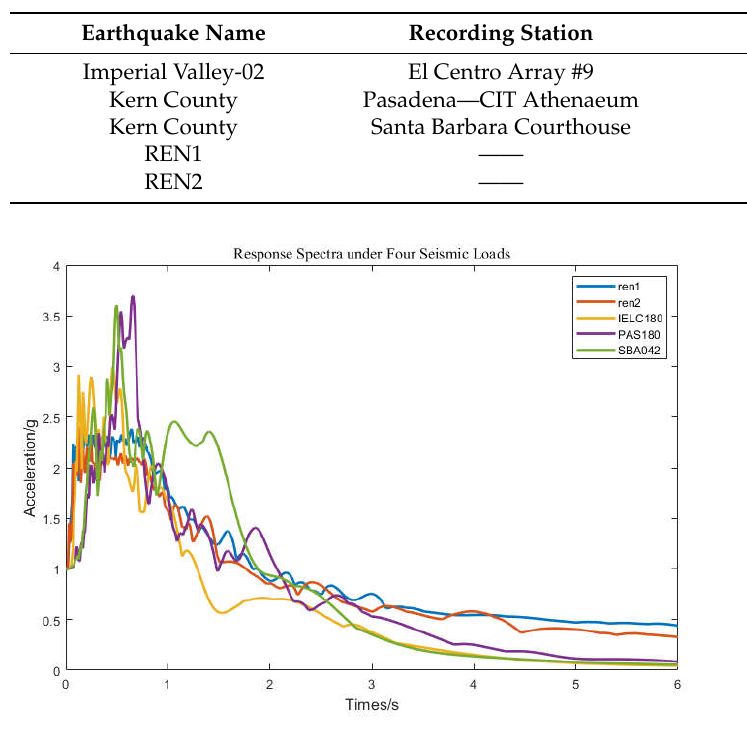
Figure 20. Seismic wave response spectrum (after peak shaving).